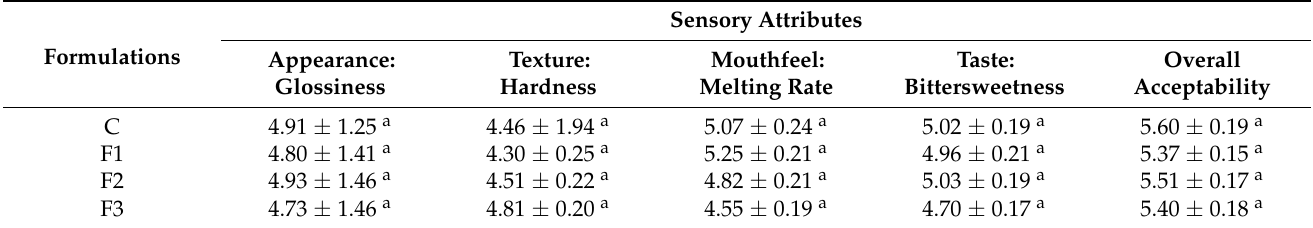
Table 9. Hedonic sensory scores of control and GABA-enriched dark